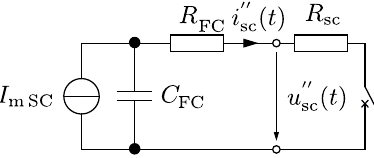
Figure 10. Equivalent circuit diagram for the short circuit case of a fuel cell.